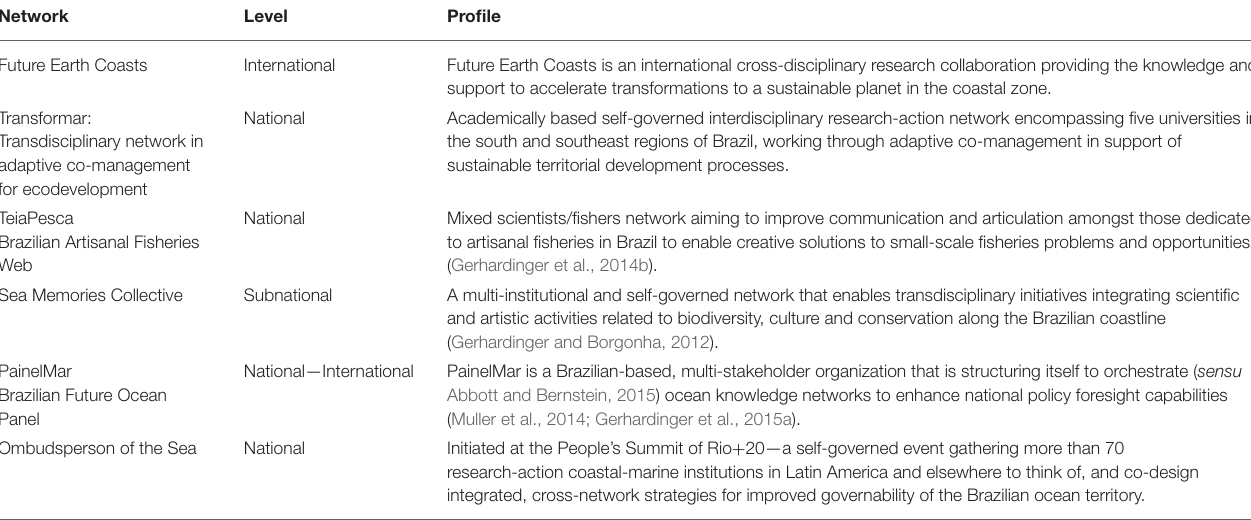
TABLE 3 | Profile of some important ocean knowledge-action networks operating in the Brazilian problem-domain.